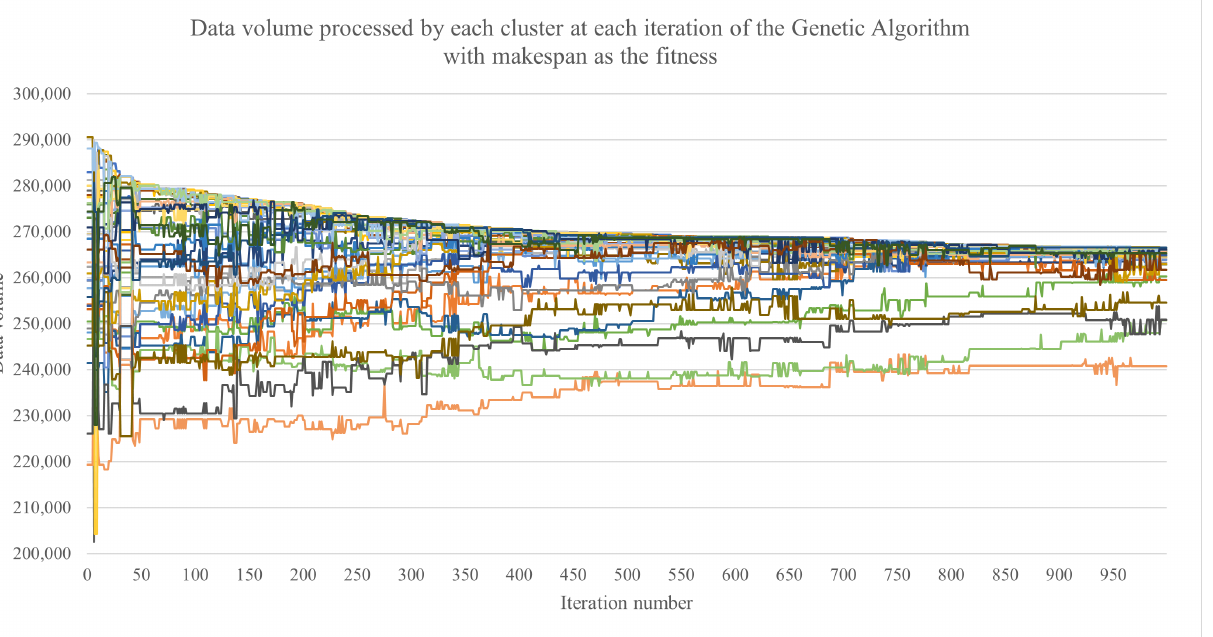
Figure 11. The evolution of the data volume that was assigned to each cluster, represented by the best fit candidate solution at each iteration of the genetic algorithm when using the makespan as the fitness function.